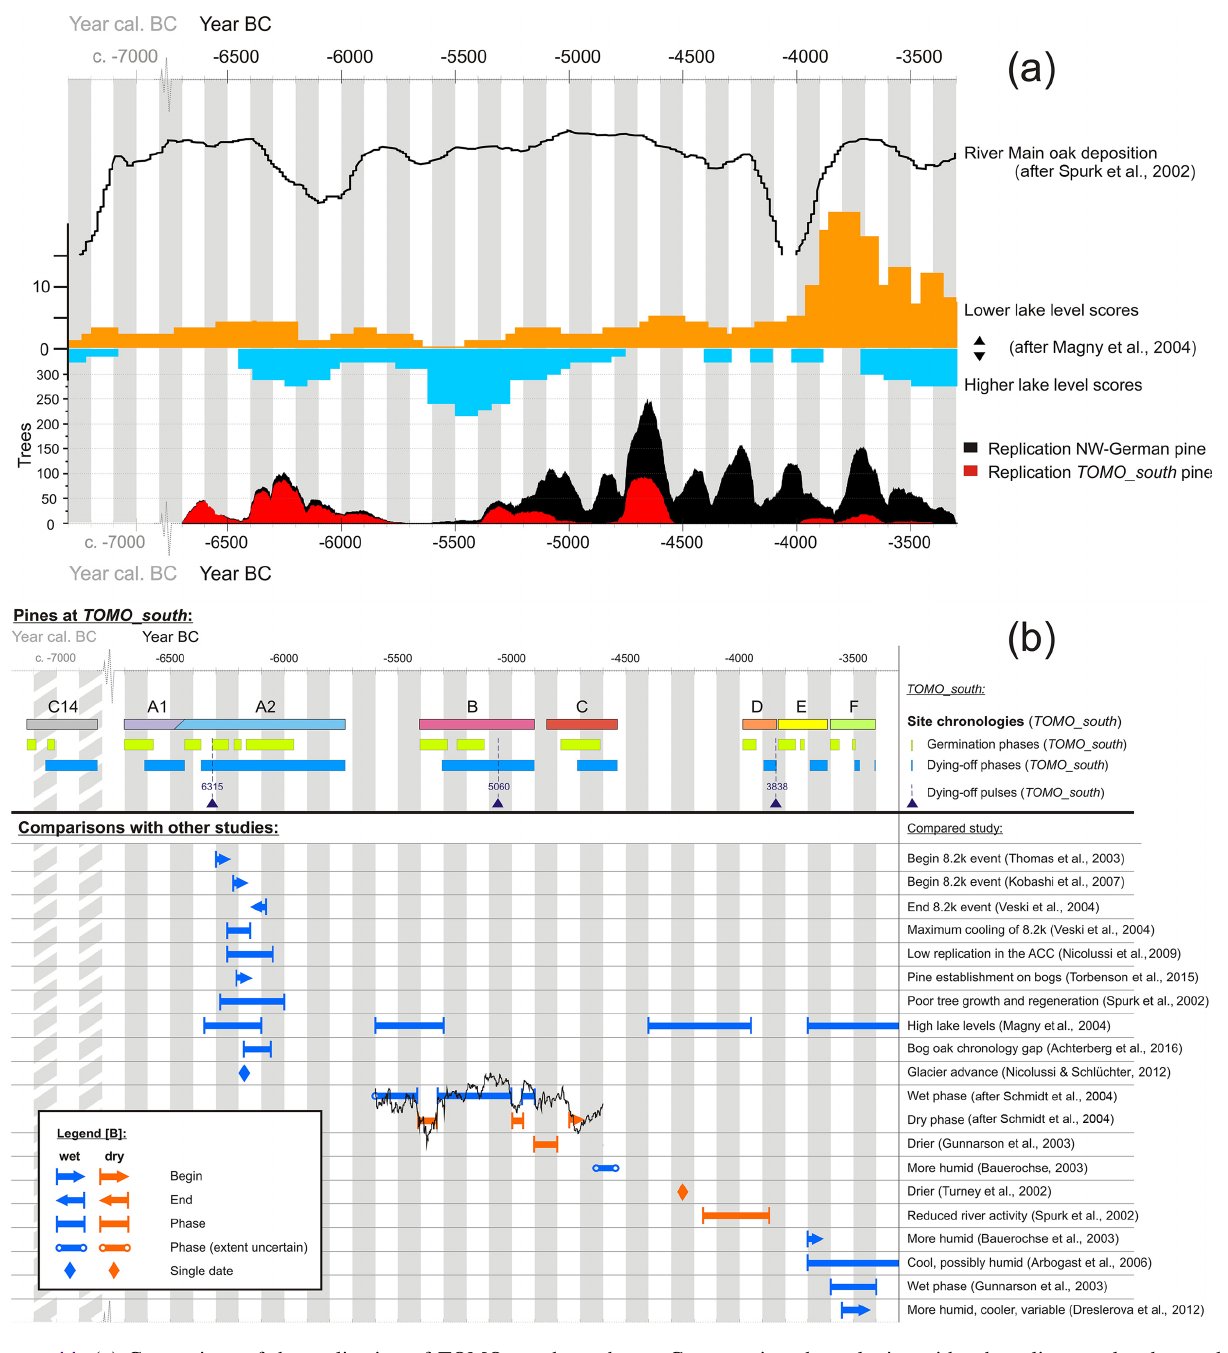
Figure 11. (a) Comparison of the replication of TOMO_south northwest German pine chronologies with other climate-related records. From top to bottom: oak deposition at the river Main (Spurk et al., 2002); scores of higher and lower lake levels in central Europe (Magny et al., 2004); replication of the northwest German pine chronology including the pines of TOMO_south, which are highlighted in red. (b) Comparison of the phases observed at TOMO_south with those of other